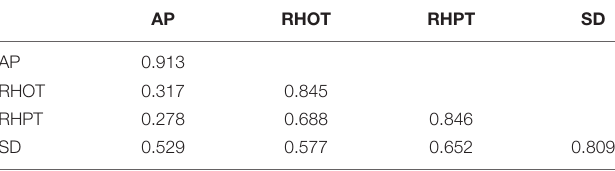
TABLE 4 | Fornell-Larcker